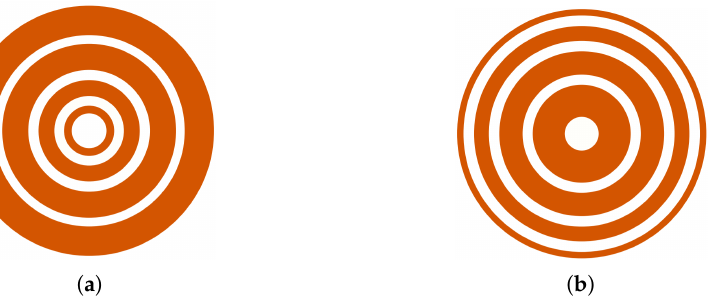
Figure 13. Planar spiral winding of two adjacent layers without turn connections for ( a ) traditional TWR (top layer) and ( b ) inverted TWR (bottom layer). This type of winding allows for less leakage inductance in the transformer as the track width is decreased from unity, dropping to a minimum before increasing the resistance as further decreases are made. Reproduced with permission from [56], IEEE,